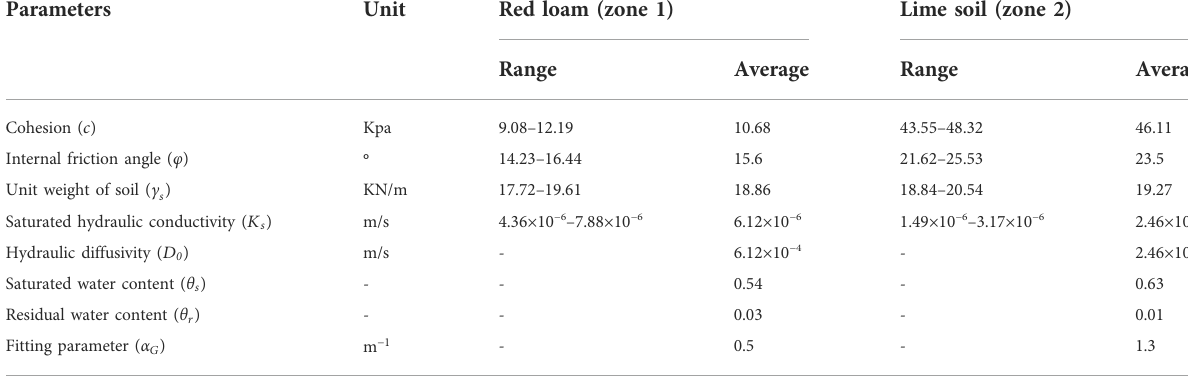
TABLE 1 The range and average of soil samples measurements in the study